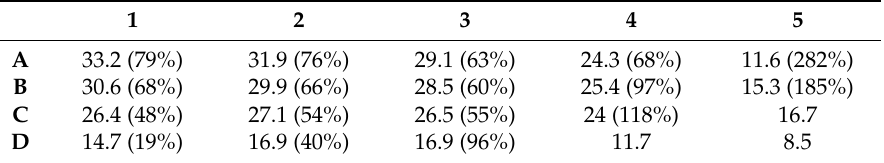
Table 5. SNR (dB) for ACE on step heating thermal data.